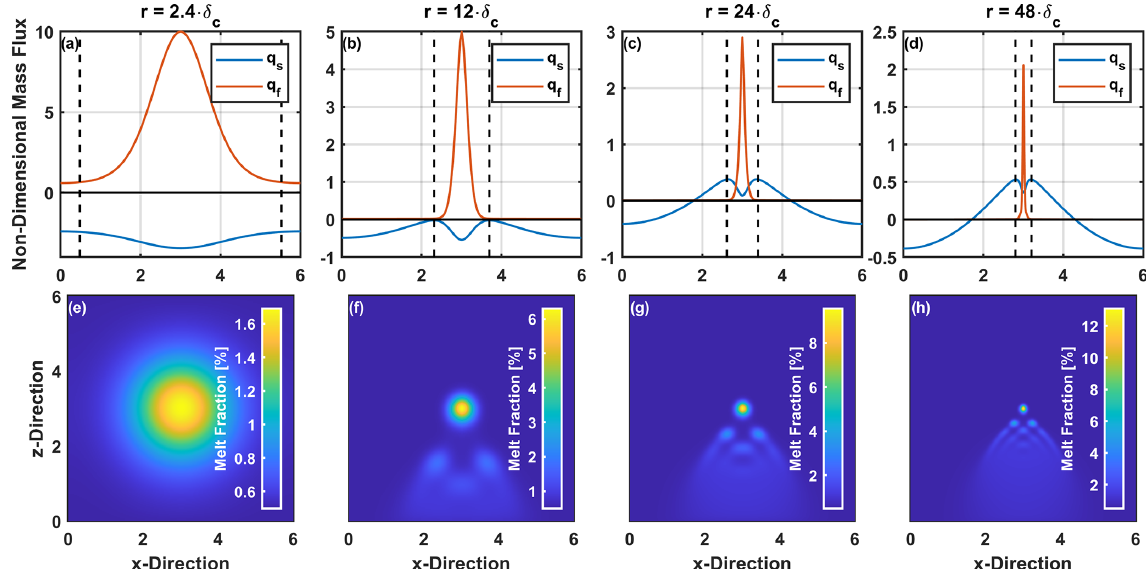
Figure 5. The upper row depicts the solid and fluid mass fluxes of a horizontal line cutting through the maximum melt fraction at time steps where the main wave has just reached the status of a solitary wave. These time steps are t (cid:48) = 002, 0068, 0155, and 0416 from left to right, respectively. The bottom row depicts the corresponding melt porosity fields. All quantities shown are